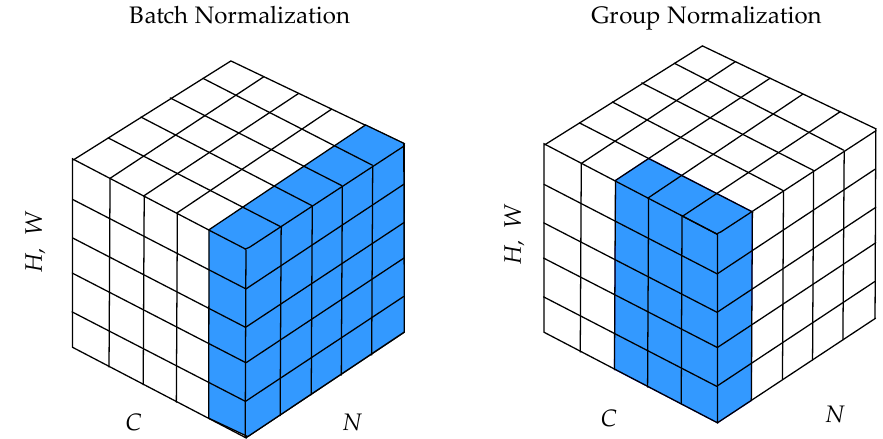
Figure 4. Normalization methods. Each subplot shows a feature map tensor, with N as the batch axis, C as the channel axis, and (H, W) as the spatial axes. The pixels in blue are normalized by the same mean and variance, computed by aggregating the values of these pixels.